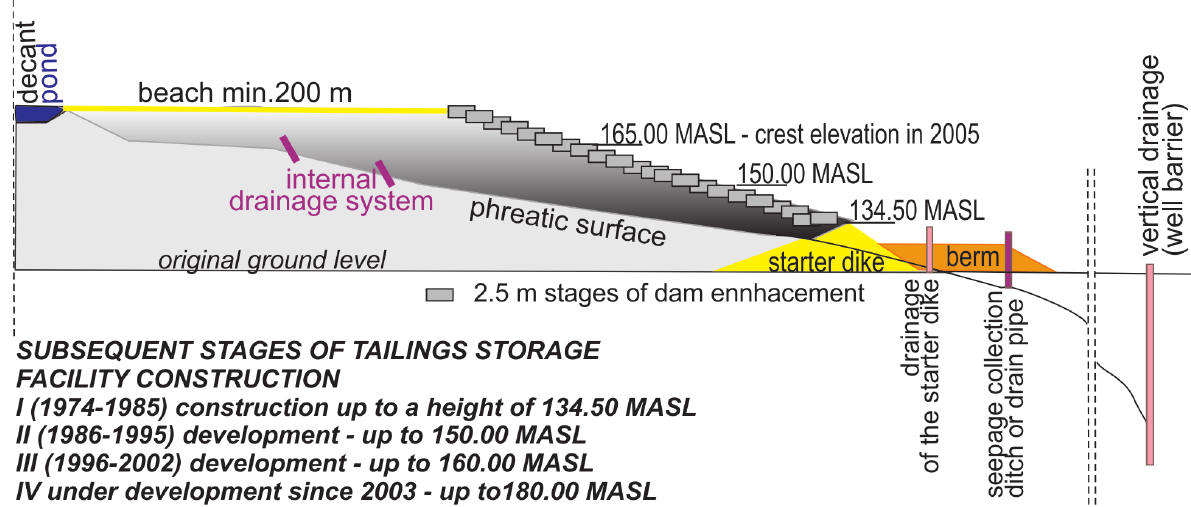
Figure 2: Consecutive phases of expansion of OUOW Żelazny Most (based on http://www.dhvhydroprojekt.com.pl/download,process,xy_800 _600,file,132/Zelazny-Most-1.jpg, access: 20.04.2018 r)